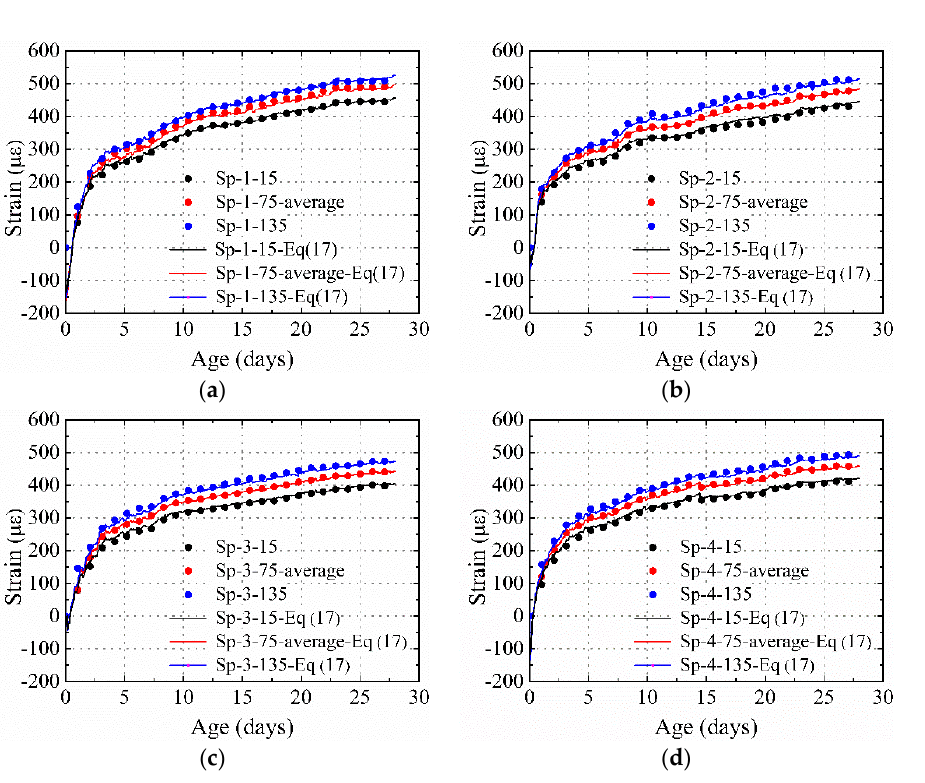
Figure 10. Comparison between results of experiment and those obtained using Equation (17): ( a )Sp-1, ( b ) Sp-2, ( c ) Sp-3, and ( d ) Sp-4.